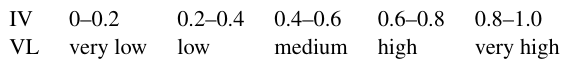
Table 1. Vulnerability level assessment due to the IV